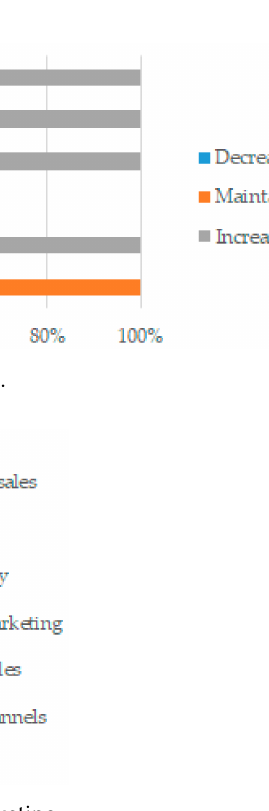
Figure 5. Use of individual sales channels for